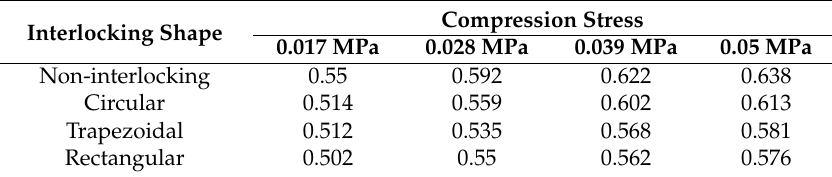
Figure 8. Experimental failure criteria for N-IMB and IMB joints under different compression stress levels: ( a ) non-interlocking; ( b ) circular interlocking; ( c ) trapezoidal interlocking; ( d ) rectangular interlocking. Table 3. Effect of compression stress on the friction coefficient.